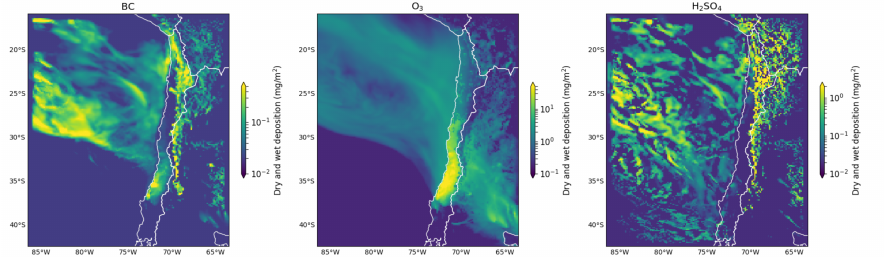
Figure 6. Accumulated deposition (dry+wet) of BC, O 3 , and H 2 SO 4 (particle phase) attributable to fires (fire-control) from 25 to 31 January. NB: deposition colormaps use a log